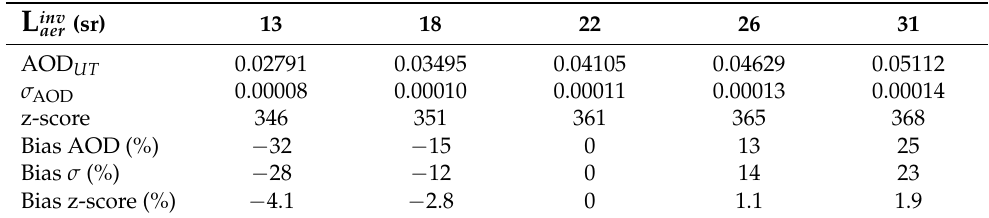
Table 2. Retrieved AOD UT and its uncertainty σ AOD for each profile of Figure 6. L inv aer is the aerosol lidar ratio for ultrafine particles used in the inversion. The detection algorithm uses the z-score, which is the ratio AOD UT / σ AOD .